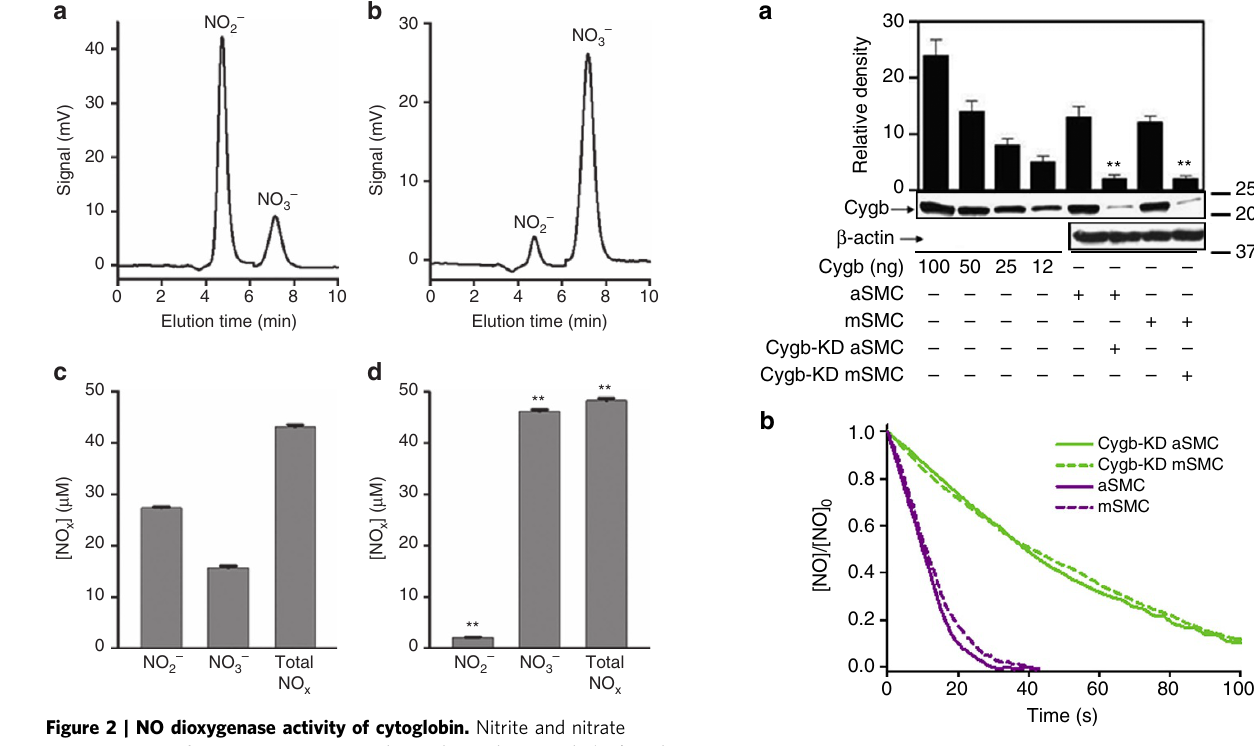
(Fig. 4b,c). Based on the 90% efficiency of knockdown of b5R, this